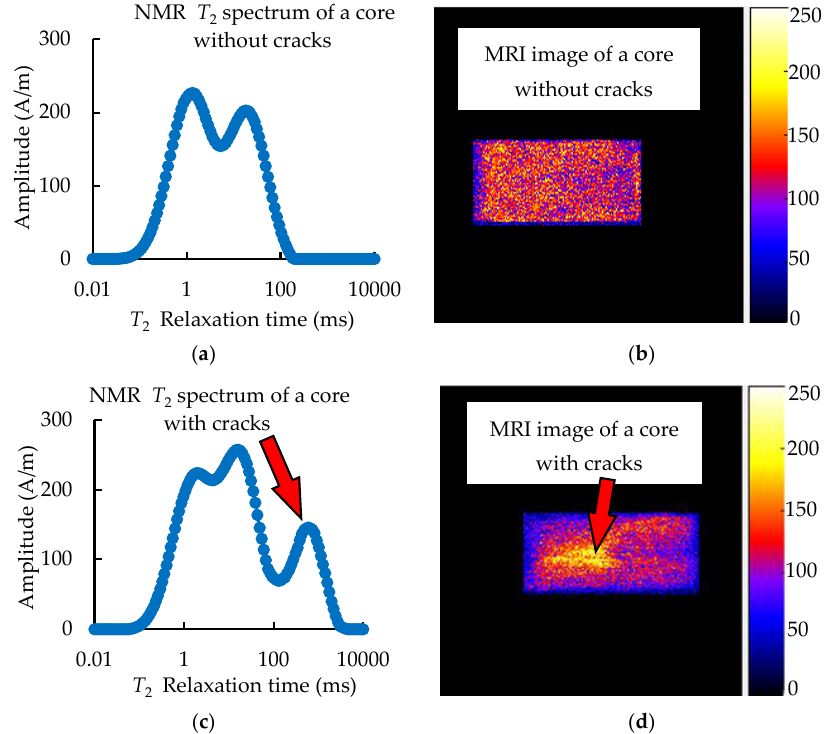
Figure 3. NMR T 2 relaxation time curves and MRI images of cores without cracks and with internal cracks. ( a ) NMR T 2 relaxation time curve of a core without cracks, (b) MRI image of a core without cracks, (c) NMR T 2 relaxation time curve of a core with cracks, (d) MRI image of a core with